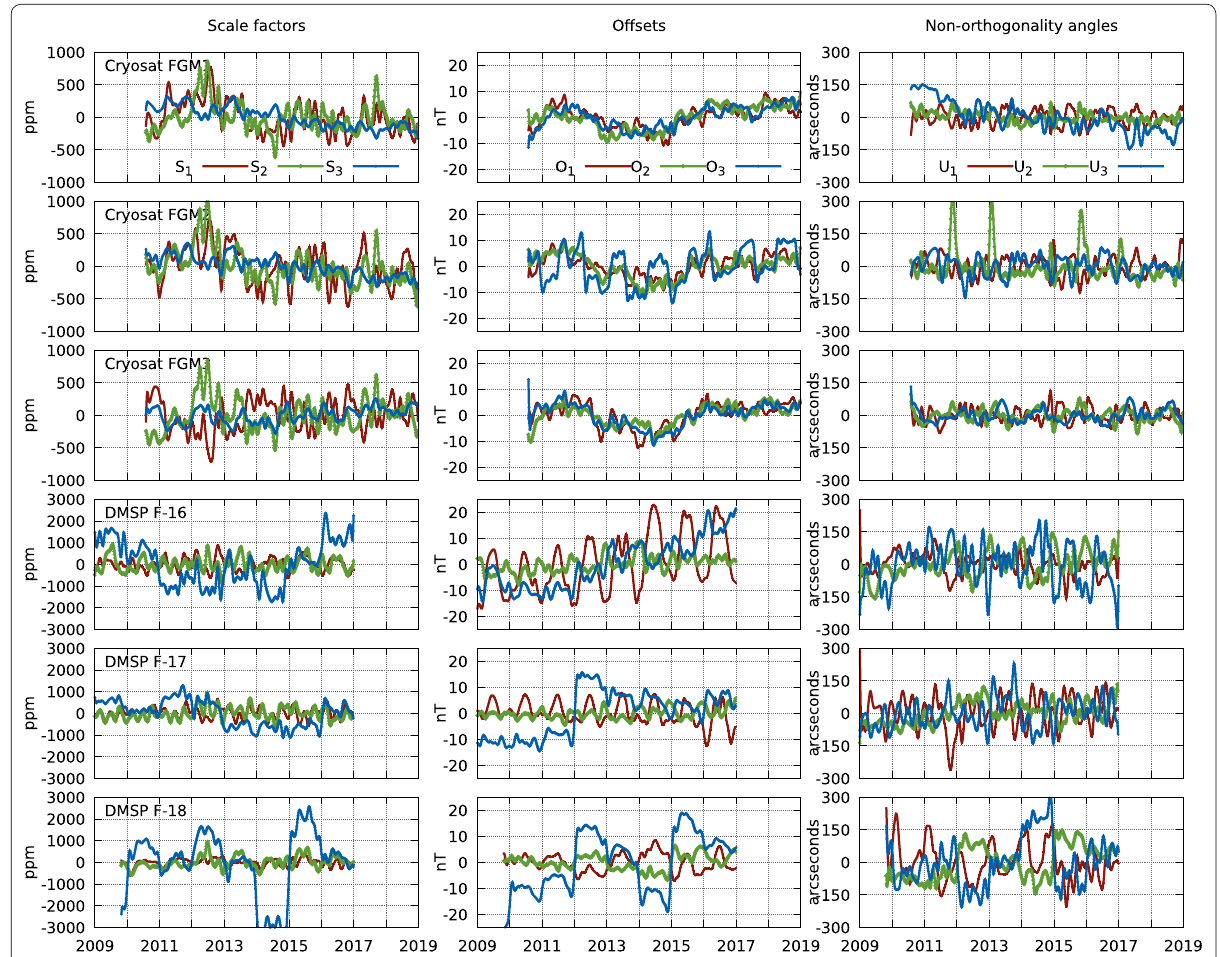
Fig. 6 Time series of (mean removed) fluxgate calibration parameters for Cryosat and DMSP derived from Model A. Left: scale factors, middle: offsets, right: non-orthogonality angles. The mean values which were subtracted are listed in Table 4